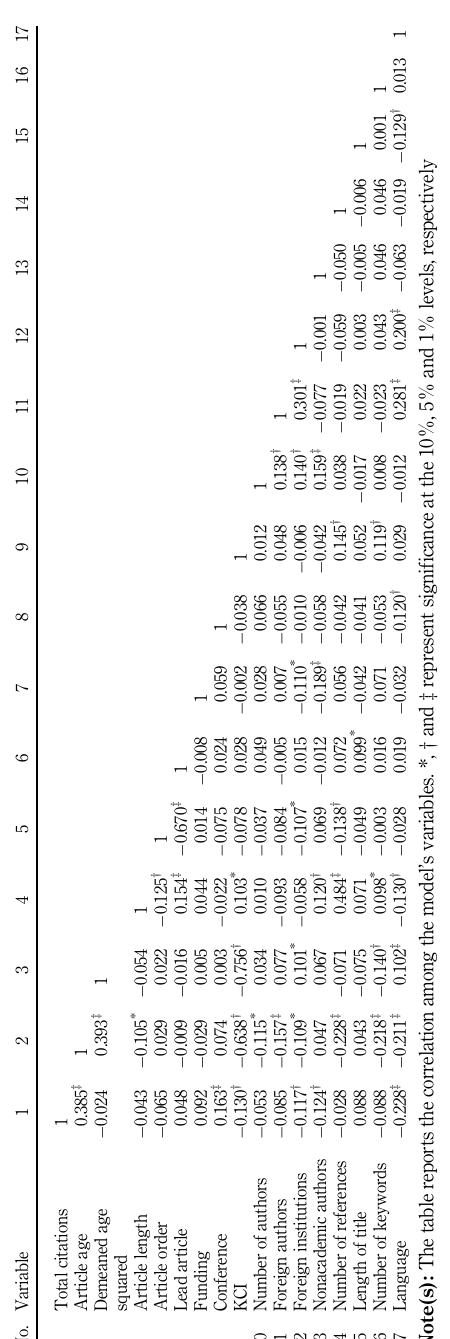
Table 9. Correlation among the model ’ s